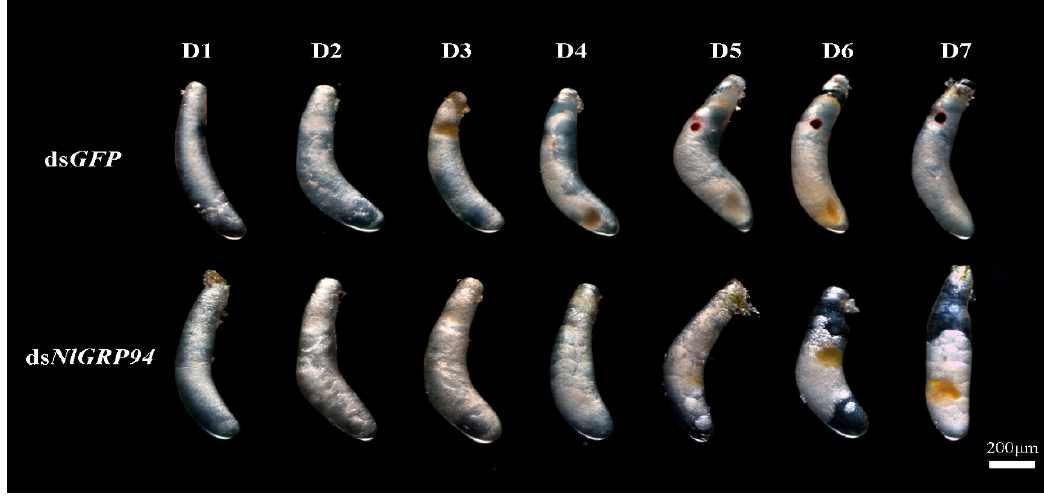
Figure 8. Embryonic development after ds NlGRP94 injection. The newly emerged females were treated with dsRNA and were mated with males. After oviposition, the eggs were dissected from the rice stem and observed every day. The development of eggs laid by ds GFP -treated females used as the parallel control.